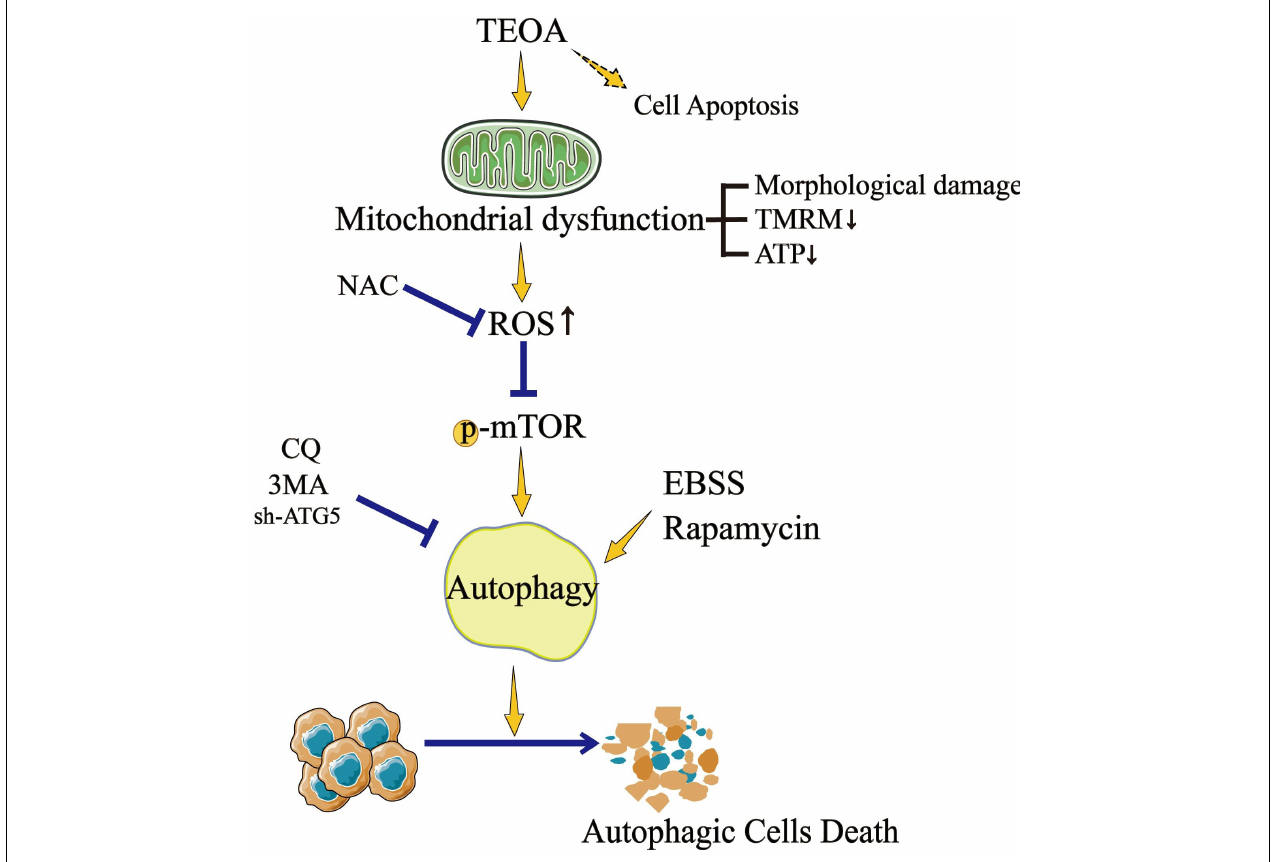
FIGURE 9 | TEOA promotes autophagic cell death via ROS-mediated Inhibition of mTOR signaling